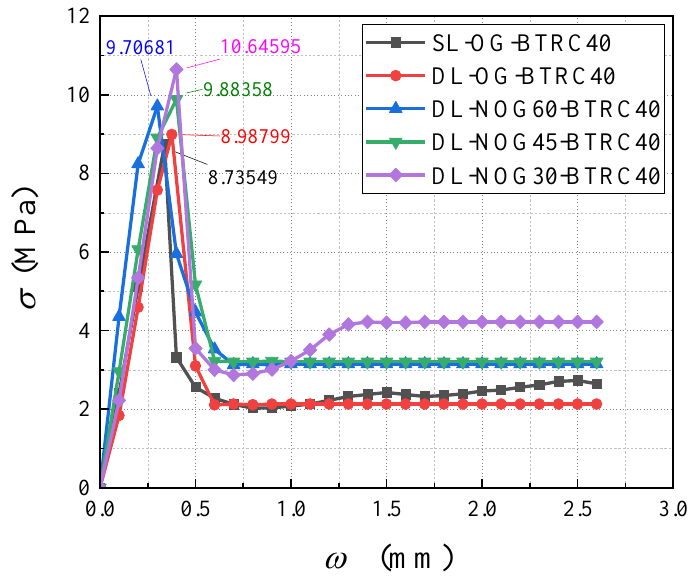
Figure 11. Bending stress–midspan deflection curve of BTRC40.